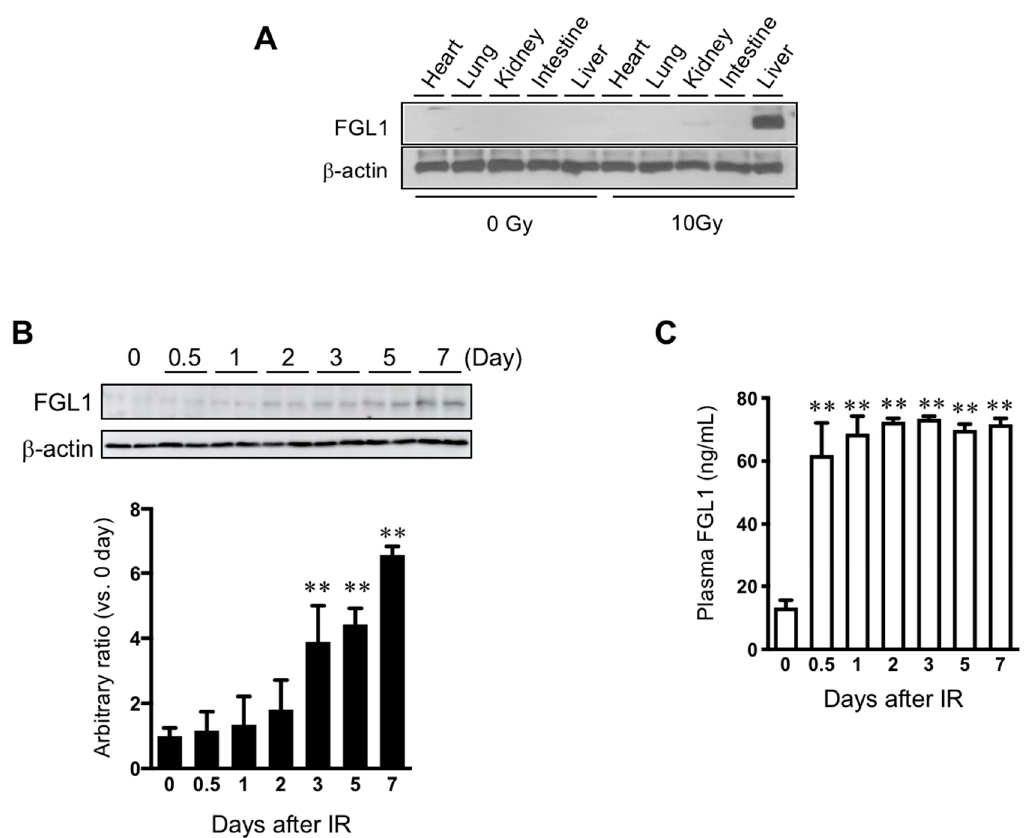
Figure 5. Expression of FGL1 in liver tissue and plasma following total body irradiation. ( A ) FGL1 expression of five internal major organs at 3 days after 10 Gy of total body irradiation. ( B ) Detection of FGL1 expression in total liver extracts by Western blotting and ( C ) in plasma by ELISA assay at days 0–7 following 10 Gy of total body irradiation. Data represent the means ± SD (** p < 0.01 compared to non-IR control, n = 4).